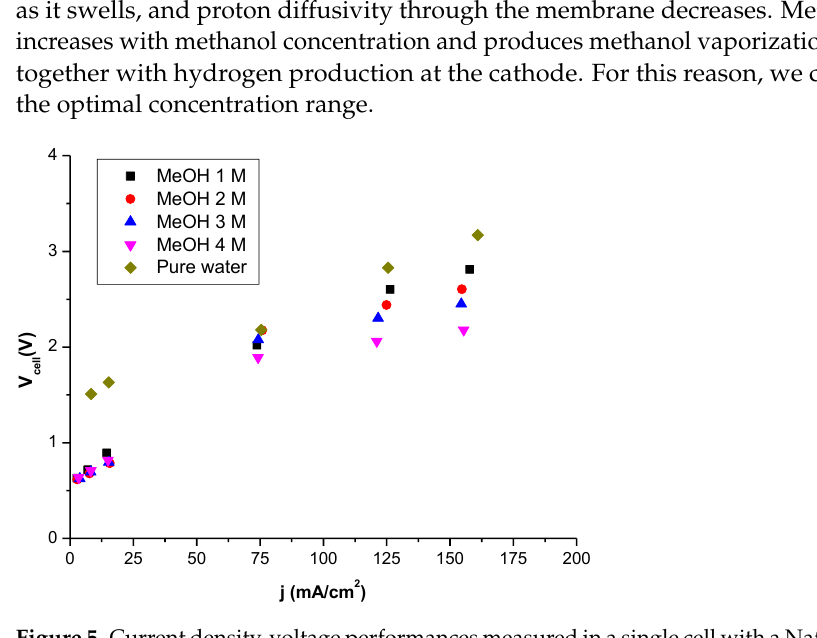
Figure 5. Current density-voltage performances measured in a single cell with a Nafion 115 membrane at different methanol (MeOH) concentrations (1, 2, 3, and 4 M) and pure water. Operating conditions: T cell = 30 °C, and P = 1 bar.